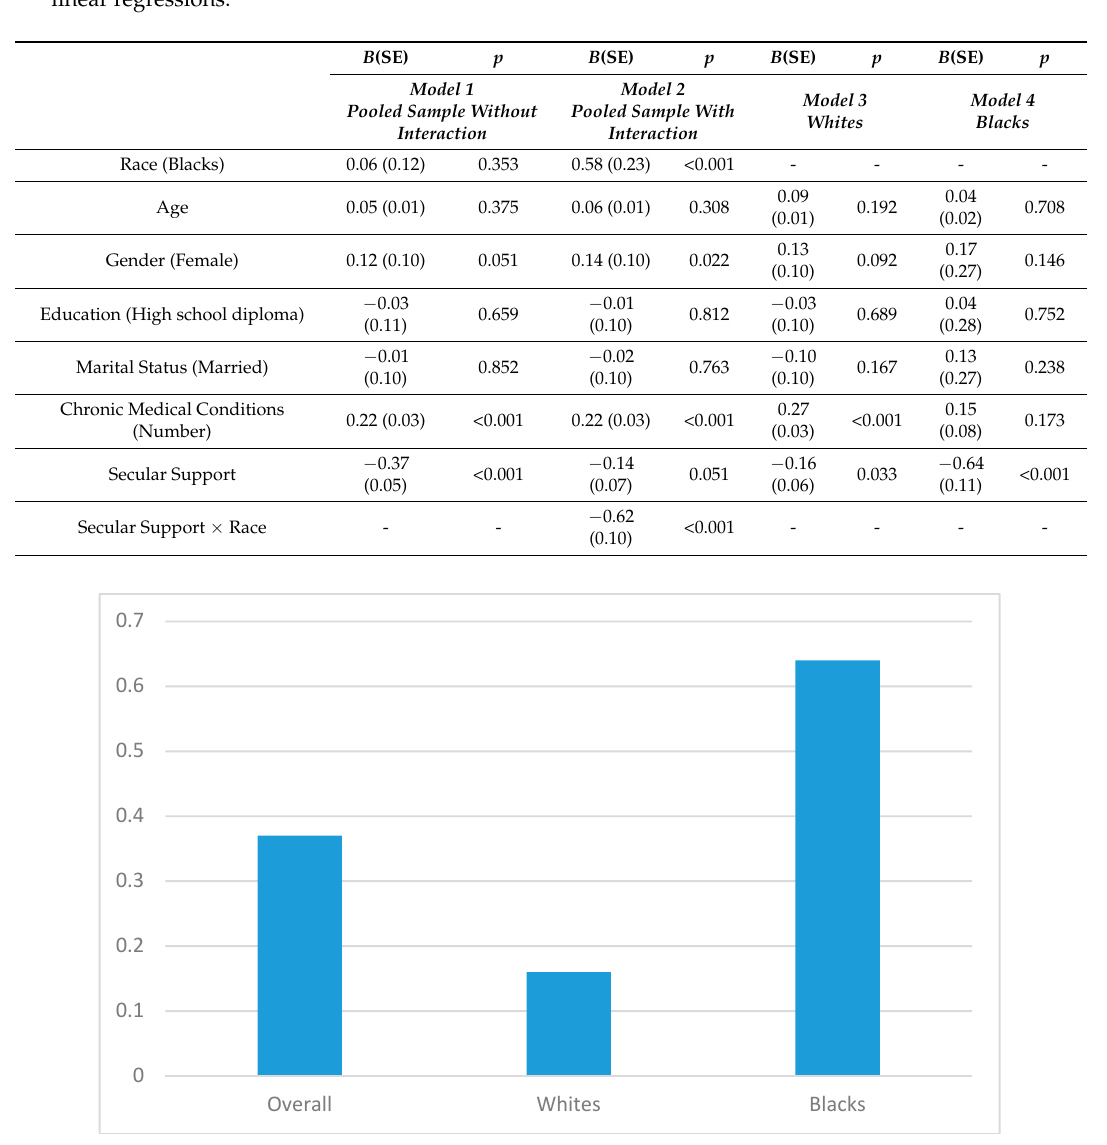
Figure 1. Protective effect of secular social support overall and by race. (Numbers are standardized regression coefficients for the effects of social support on depressive symptoms).